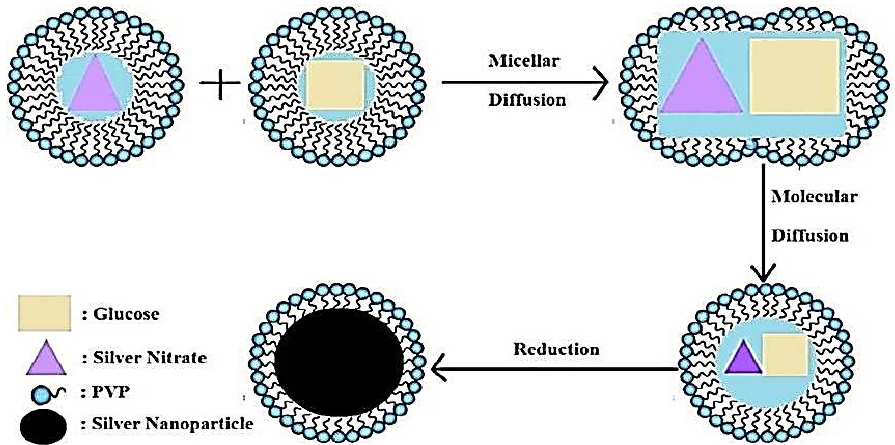
Figure 2. Mechanism of using PVP stabilizer for silver nanoparticles.